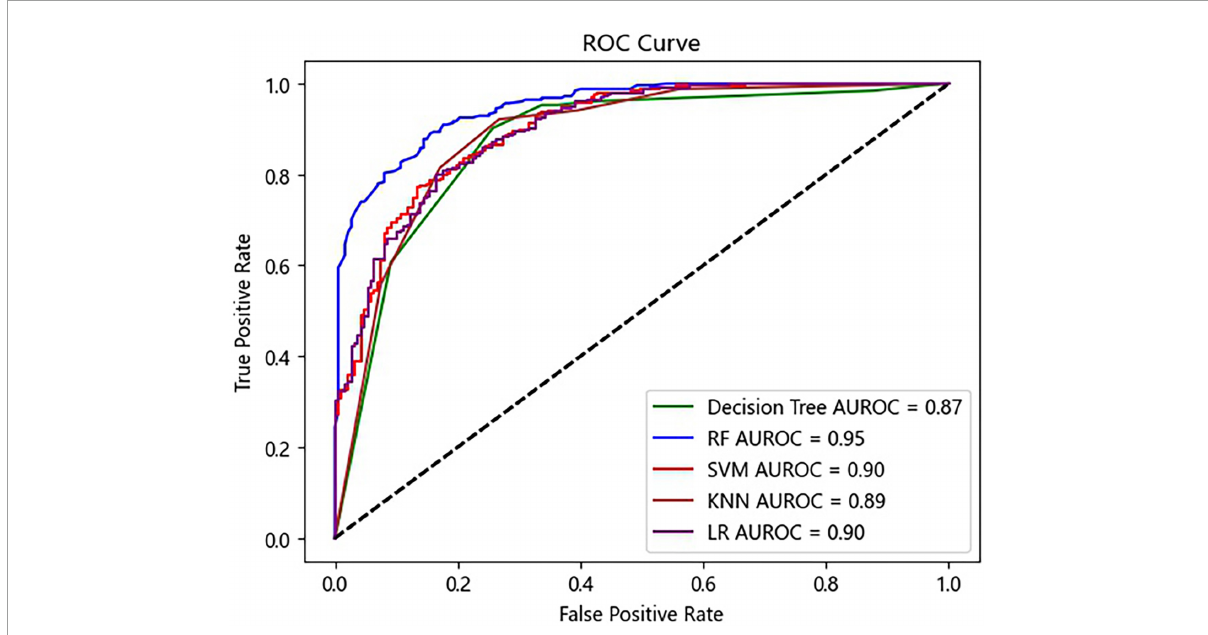
FIGURE5 Receiver operating characteristic (ROC) curves of the prediction model using ten selected features. RF, random forest; SVM, support vector machine; KNN, K-nearest neighbor; LR, logistic